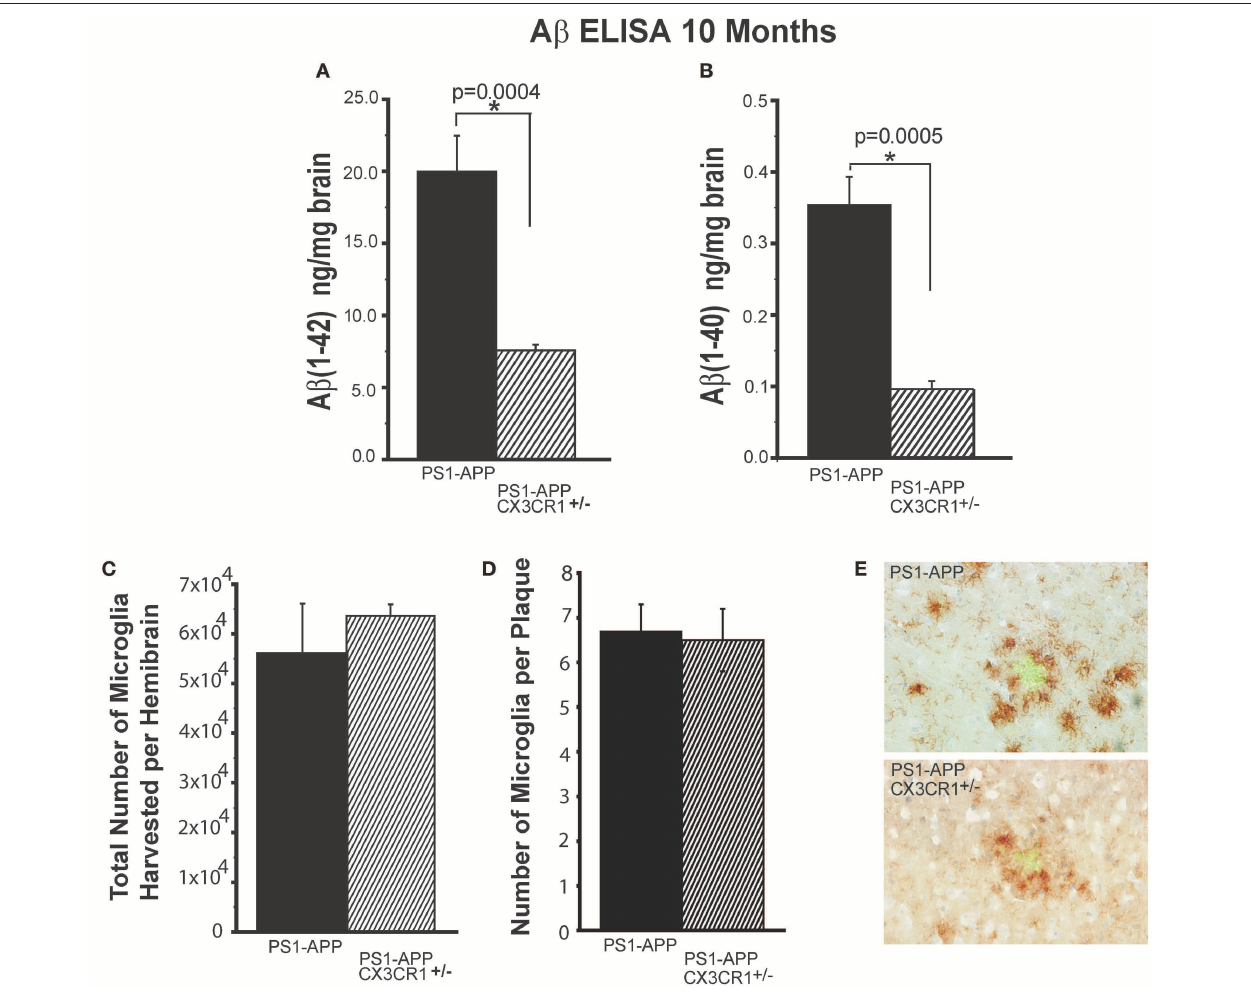
FIGURE 2 | Partial CX3CR1 deficiency affects A β levels but does not affect total microglial numbers or the numbers of plaque-associated microglia. Quantification of (A) A β (1-42) and (B) A β (1-40) by ELISA in brain homogenates of 10-month old mice (Numbers represent mean ng of A β /mg brain ± SEM). (C) Quantification of total number of microglia isolated per hemisphere. (D) Quantification of the number of CD11b + cells associated per plaque ≥ 75 µ m in diameter. (E) Representative micrographs of plaques (green) and microglia (brown) in PS1-APP and PS1-APP-CX3CR1 + / − mice. For all measurements in this figure, n = 6 for PS1-APP, n = 7 for PS1-APP-CX3CR1 + / − . For (E) 80 plaques were counted per genotype. * represent statistically